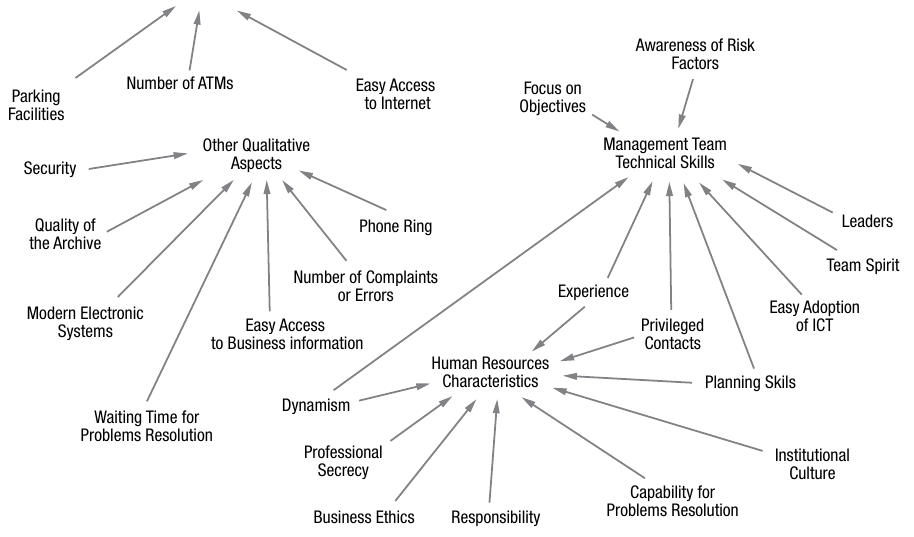
Fig. 2. Part of the strategic map